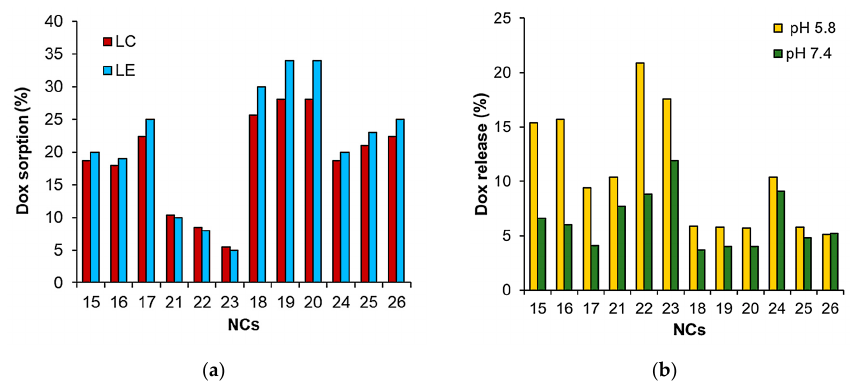
Figure 6. ( a ) Sorption and ( b ) desorption of Dox on NCs 15 – 26